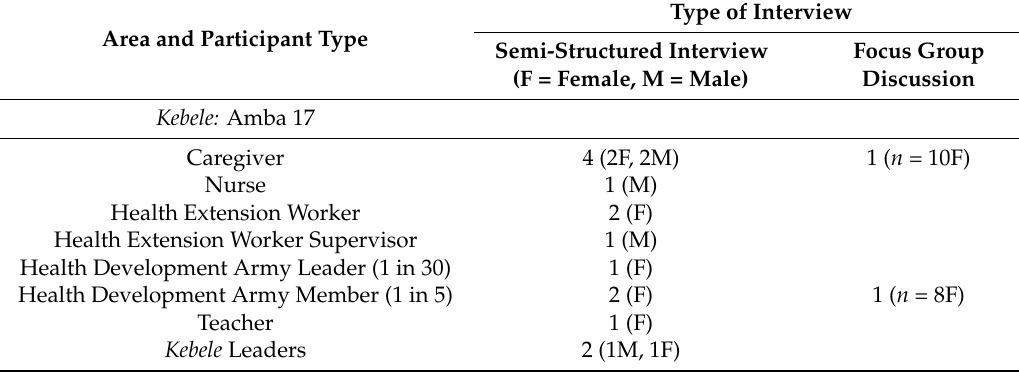
Table 2. Number of interviews and focus groups by area and participant type (excluding verification interviews and focus group discussions